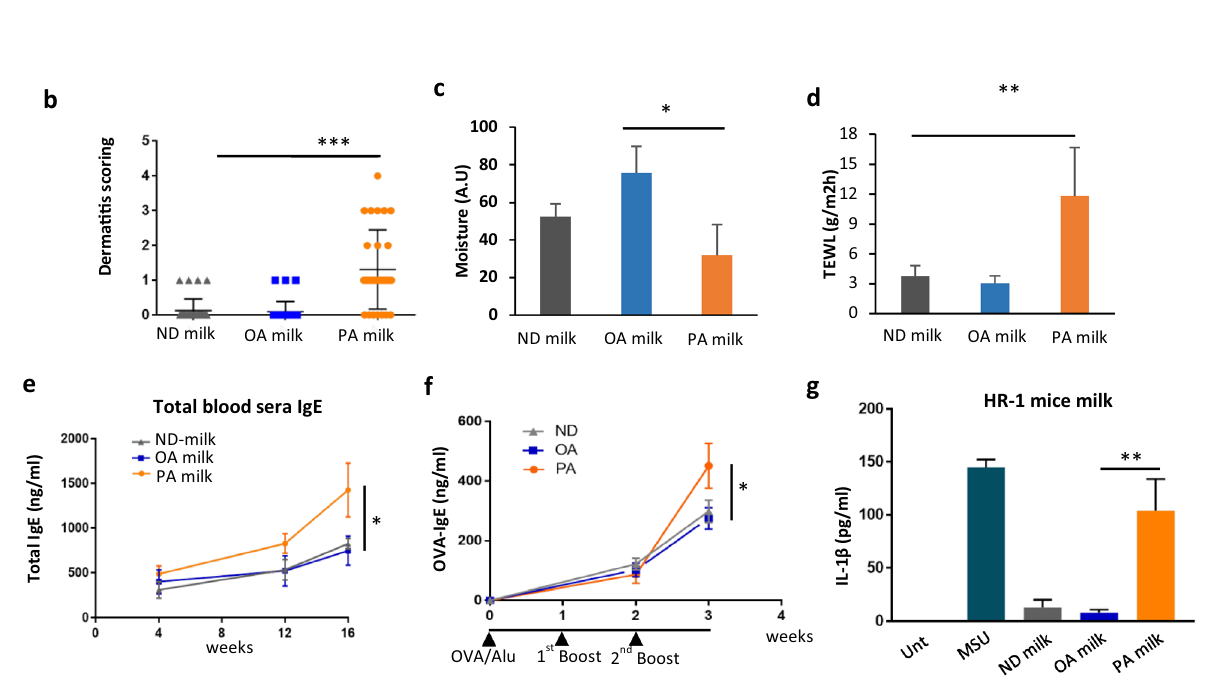
Figure 2. HR-1 mice offspring fed with maternal milk high in palmitic acid developed eczema. ( a ) Mice model of milk feeding. At 19 days nearing labor, pregnant HR-1 mice were fed with normal diet (ND) or chow diet added with 8% (w/w) saturated fatty acid, palmitic acid (PA) or 8% (w/w) unsaturated fatty acid, oleic acid (OA). In the case of PA milk or OA milk group, after birth, offspring from ND maternal mice were swapped to be breastfed by mice given diet high in PA or OA. Food was changed to normal diet when offspring started to feed on their own. ( b ) Dermatitis score of mice (n = 32 mice/group) at 15 weeks post weaning (p.w.) were evaluated base on (1) erythema/ hemorrhage, (2) scarring/dryness, (3) edema, (4) excoriation/erosion, scored as 0 (none), 1 (mild), 2 (moderate) and 3 (severe). The sum of the individual scores was taken as the dermatitis score. ( c ) Skin moisture and ( d ) transepidermal water loss of mice (n = 5 mice/group) at 15 weeks p.w. were determined using the Delfin MoistureMeterSC and Delfin VapoMeter, respectively. TEWL measurements were made on the lesional area of the skin. ( e ) Total blood serum IgE (n = 5 mice/group) was determined using the IgE FlowCytomix Simplex kit (eBioscience) according to the manufacturer’s manual. ( f ) Mice at 4 weeks p.w. (timeline = 0 week) (n = 5 mice/group) were sensitized with an intraperitoneal (i.p.) injection of 10 μg of OVA and 1 mg of alum, and re-sensitized twice at one week intervals. OVA-specific IgE in blood serum was determined with DS mouse IgE ELISA (OVA). ( g ) Milk of maternal mice given OA or PA diet (n = 3) were collected and examined for DAMPs activity with IL-1β ELISA. Results shown are representatives of at least three independent experiments. Data are represented as mean ± SD. * P < 0.05; ** P < 0.01; *** P < 0.001, one-way ANOVA. Data are analyzed with Prism8 (version 8.4.3, https:// www. graph pad. com/ scien tific- softw are/